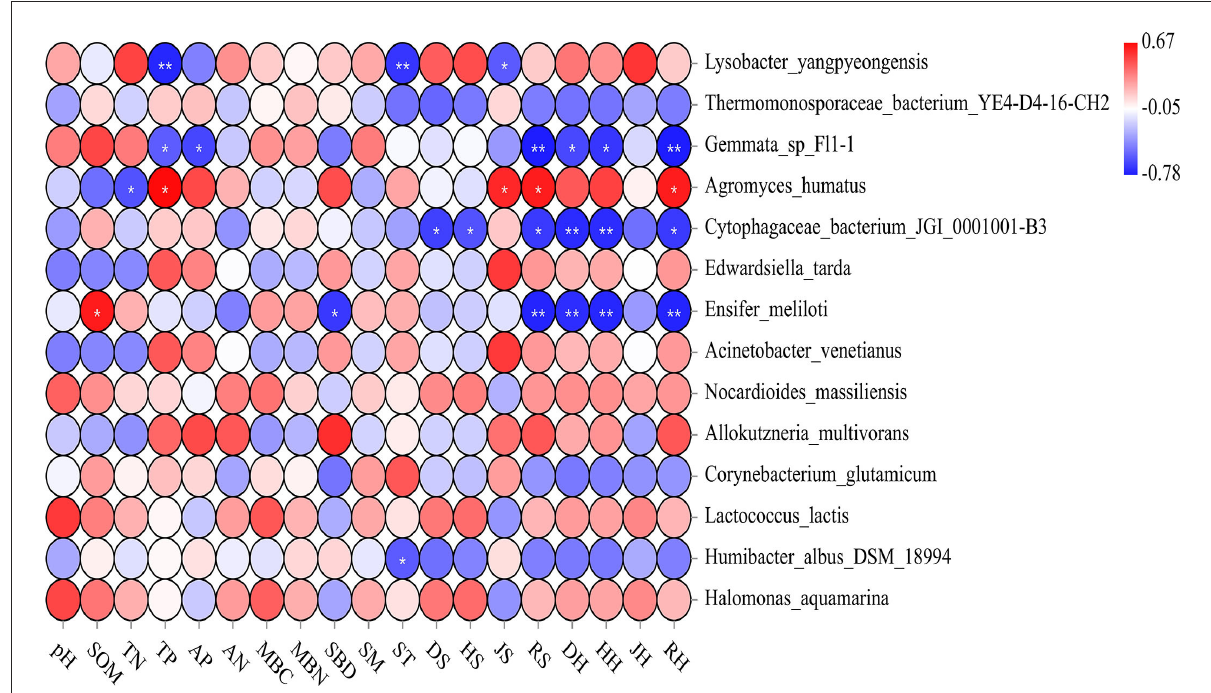
FIGURE6 A heat map depicts the relative abundances of indicator species and Spearman’s correlations between abundances of indicator species and environmental factors. Double asterisks indicate a p- value < 0.01; single asterisk indicates a p- value < 0.05. RH, DH, JH, and HH denote the richness index, the Simpson index, the Pielou index, and the Shannon index in the herb layer, respectively. RS, DS, JS, and HS denote the richness index, the Simpson index, the Pielou index, and the Shannon index in the shrub layer, respectively. This notation signifies the same meanings in the text. “S” stands for small gaps; “M” stands for medium gaps; and “L” stands for large